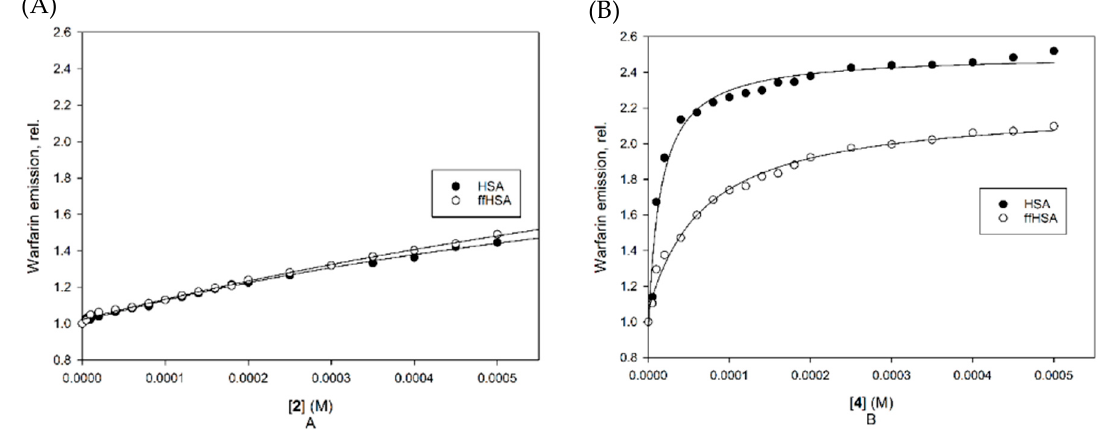
Figure 4. Fluorescence emission of warfarin (excitation 320 nm, emission 380 nm) in the presence of 1 μ M albumin and increasing concentrations of 2 ( A ) and 4 ( B ).